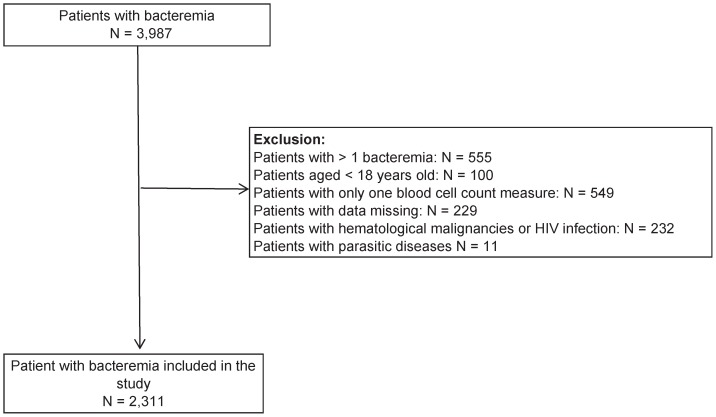
Cases analyzed, exclusion criteria and study population.